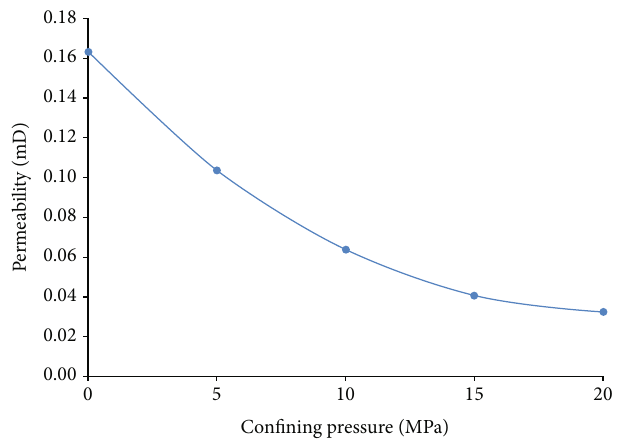
Figure 9: The permeability versus con fi ning pressure for fractured-vuggy sample.